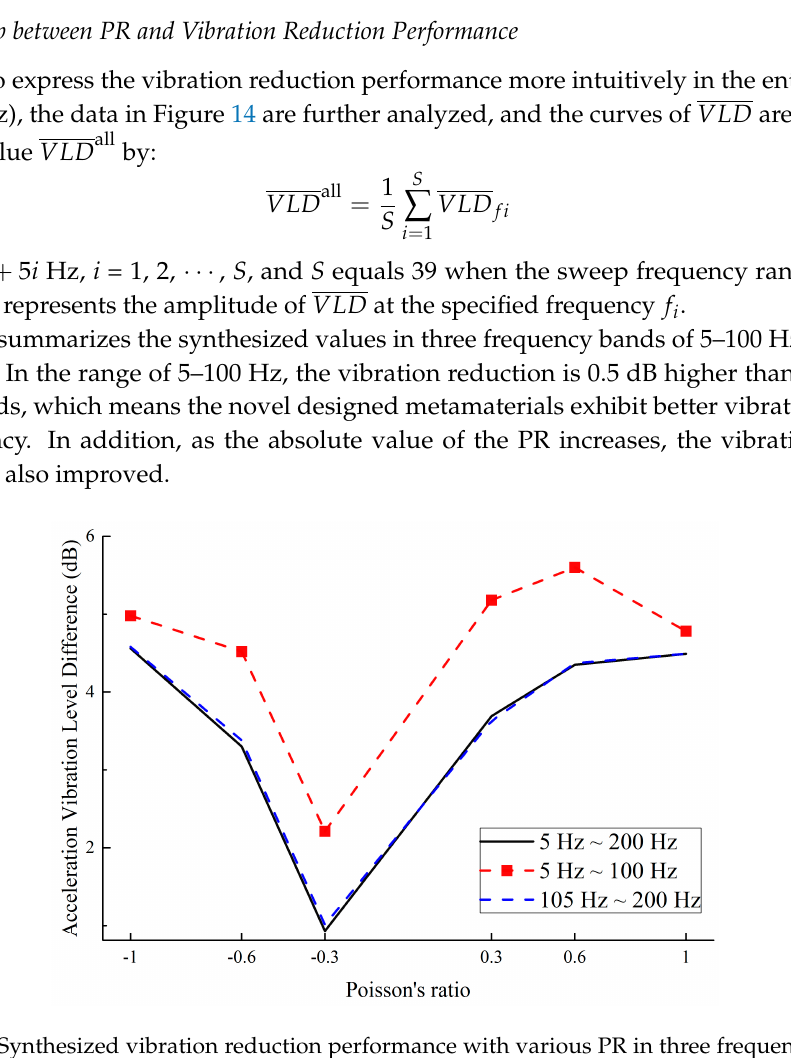
Figure 15. Synthesized vibration reduction performance with various PR in three frequency bands: 5–200 Hz, 5–100 Hz and 105–200 Hz.